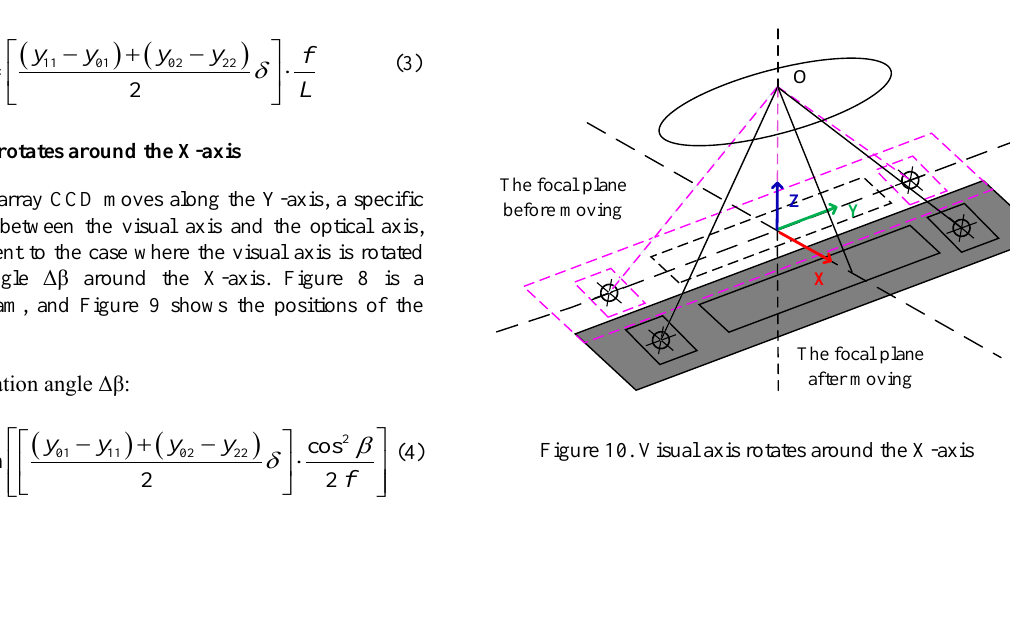
3.3 Visual axis rotates around the Y-axis When the linear-array CCD moves along the X-axis, a specific angle is formed between the visual axis and the optical axis, which is equivalent to the case where the visual axis is rotated by a certain angle ∆α around the Y-axis. Figure 10 is a simulation diagram, and Figure 11 shows the positions of the spots.